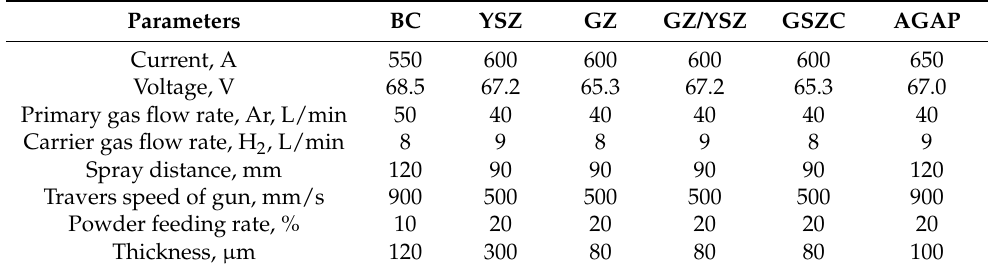
Figure 1. ( a ) Morphologies and ( b ) particle size distribution of Al 2 O 3 /Gd 2 O 3 granulated powder. Table 1. Plasma spraying parameters for TBCs deposition.